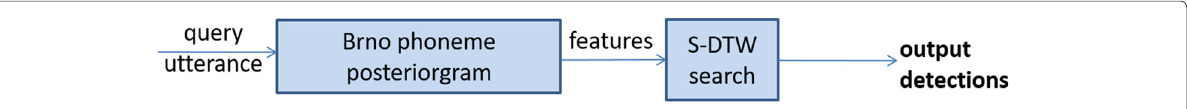
Fig. 3 D-ELiRF-UPV-Posteriorgram+DTW-based QbE STD system